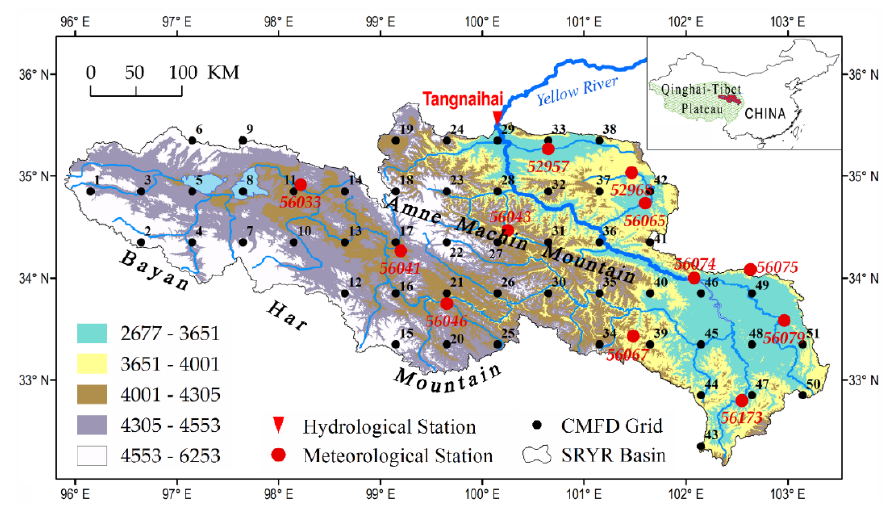
Figure 2. The source region of the Yellow River with 12 meteorological stations (in red) and 51 CMFD (China Meteorological Forcing Dataset) grids (in black).